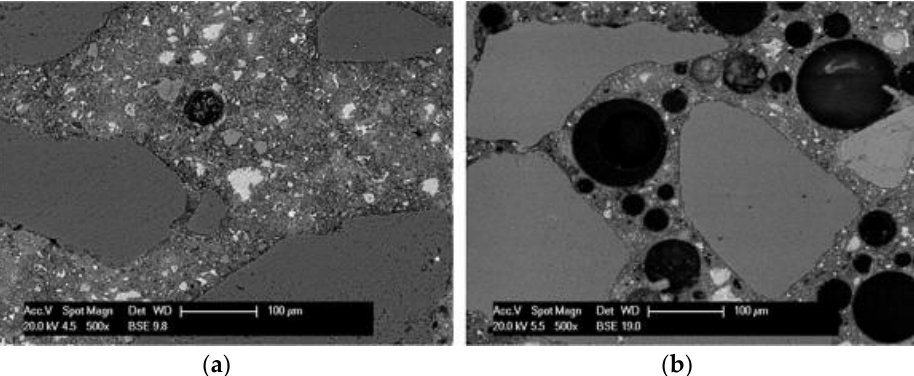
Figure 2. ( a ) Reference mixture containing no foaming agents or foams SEM images, ( b ) foamed concrete mixture SEM image. Reprinted/adapted with permission from Ref. [84]. 2015, Elsevier Science & Technology Journals.